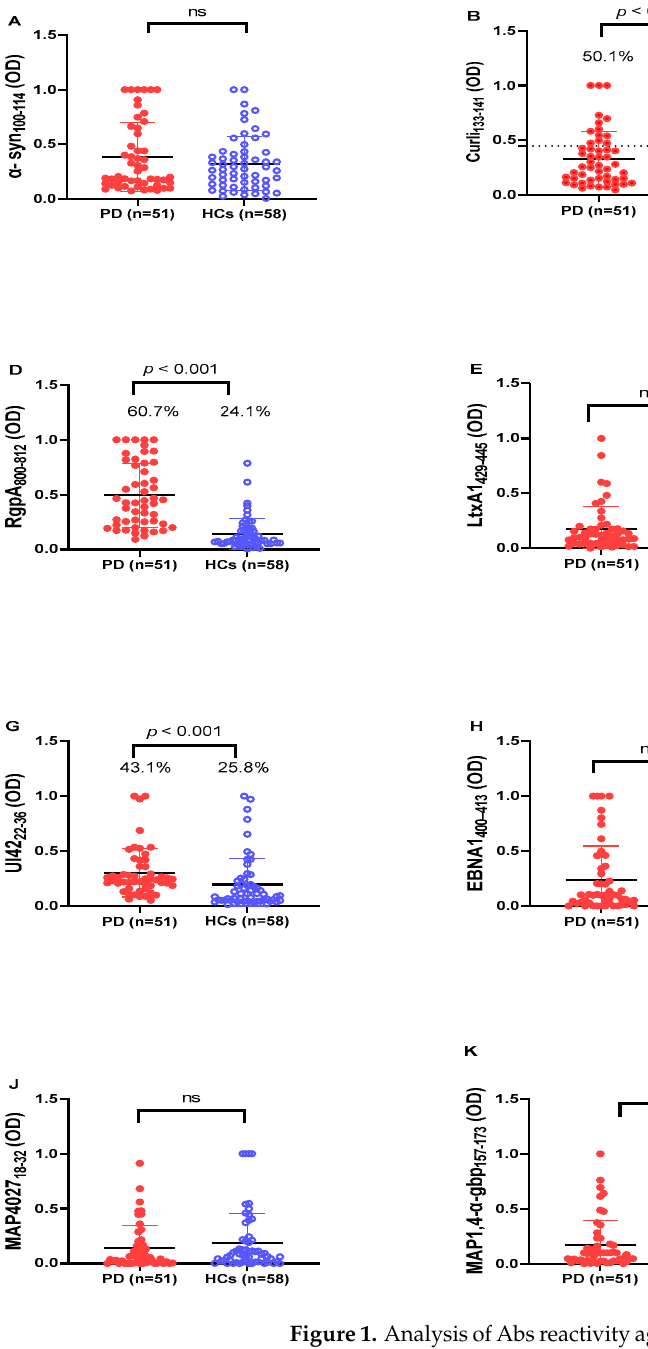
Figure 1. Analysis of Abs reactivity against human α -syn and pathogenic microorganism-derived pep- tides in PD patients and HCs. Serum samples were tested with indirect ELISA assay to plate-coated ( A ) α -syn 100–114 , ( B ) Curli 133–141 , ( C ) Kpg 328–339 , ( D ) RgpA 800–812 , ( E ) LtxA1 429–445 , ( F ) LtxA2 64–80 , ( G ) UI42 22–36 , ( H ) EBNA1 400–413 , ( I ) BOLF 1305–320 , ( J ) MAP4027 18–32 , ( K ) MAP1,4- α -gbp 157–173 , ( L ) MAP3865c 125–133 peptides. The dotted lines represent the cut-off values calculated by ROC analysis; In the upper section of the graph, are indicated the Mann–Whitney p -value and the percentage of positive patients’ values calculated by the Fisher’s exact test. Statistical significant levels showed at p < 0.05, ns: not significant.